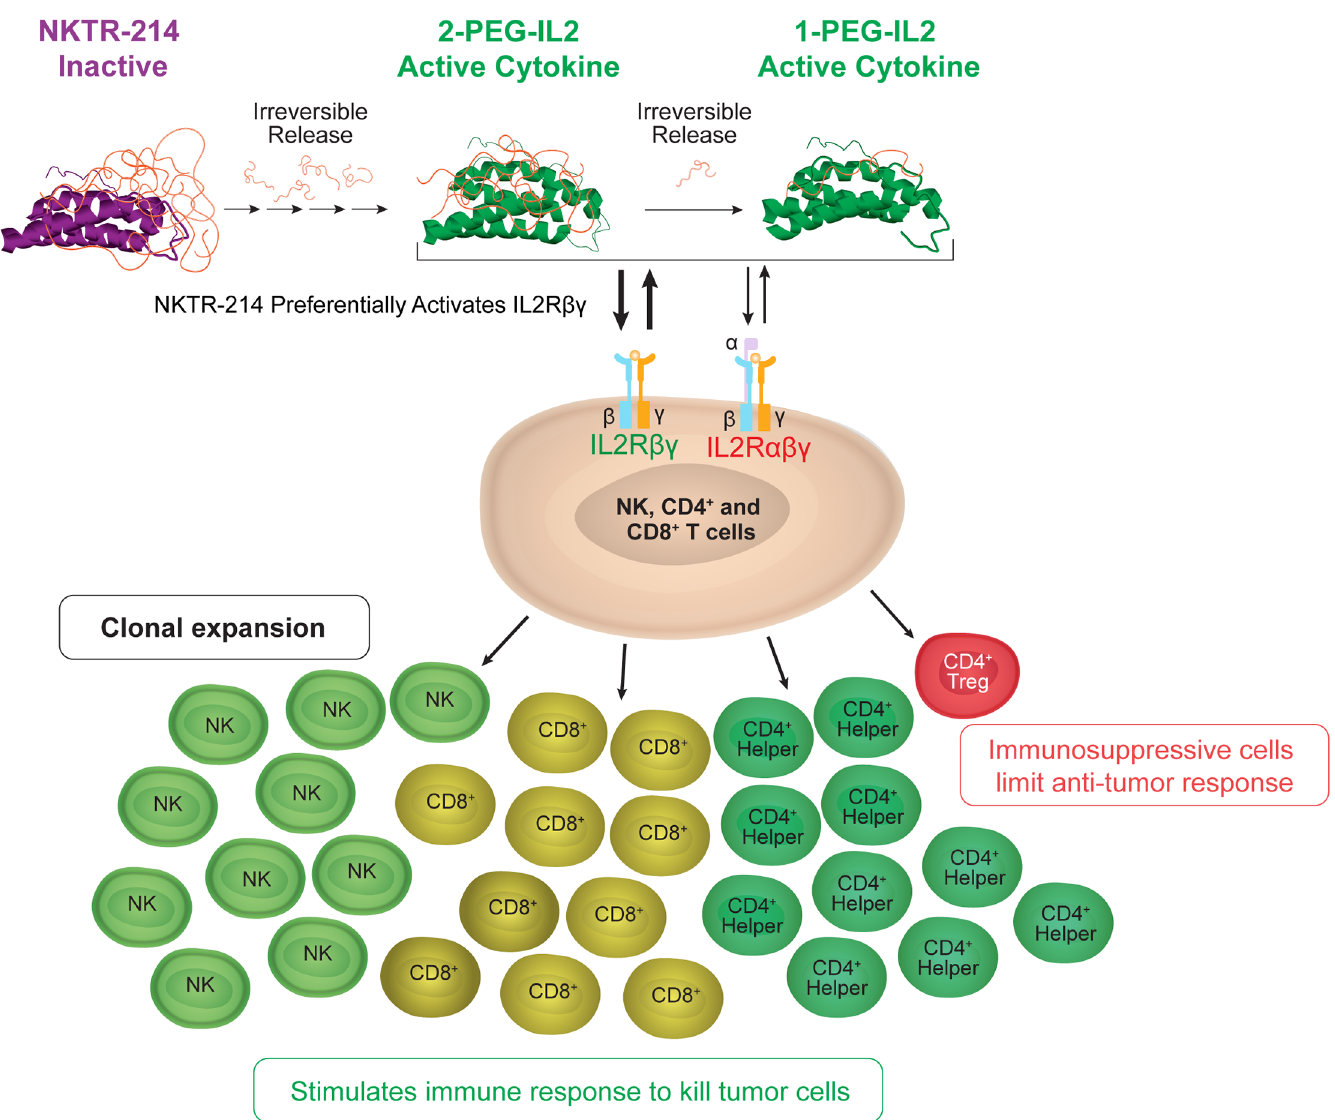
Fig 1. NKTR-214delivers a controlled, sustained, and biased signal through the IL2 receptor pathway. NKTR-214 is a CD122-biased cytokine agonistconjugatedwith multiplereleasablechains of PEG locatedat the interface of IL2 and IL2R αβγ . The PEG chains slowly release at physiological pH, creating conjugated-IL2 species with fewer PEG chains and increasedbioactivity. Sustained signalingthrough the heterodimeric IL2 receptorpathway (IL2R βγ )preferentially activates and expandseffector CD8 T and NK cells over